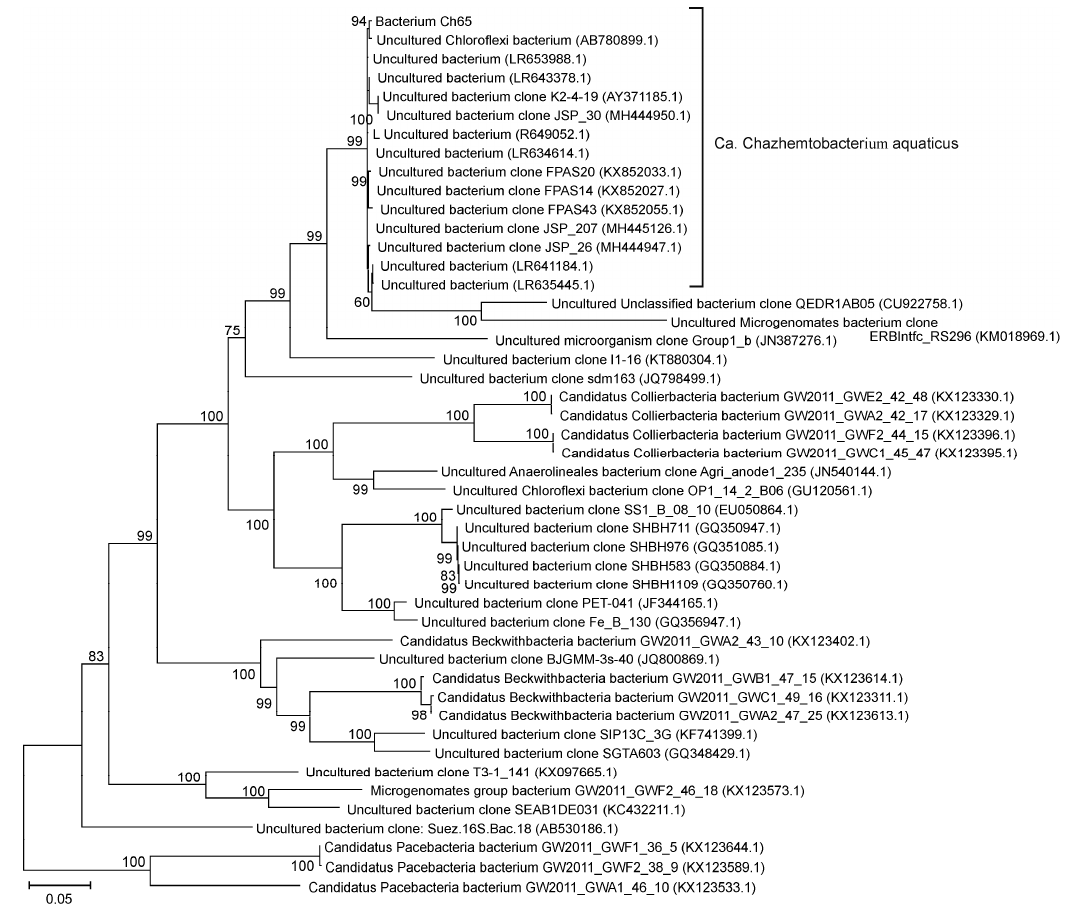
Figure 3. Position of Ch65 genome in the maximum likelihood 16S rRNA gene phylogenetic tree. GenBank accession numbers are shown after the clone names. The scale bar represents substitutions per nucleotide base. Bootstrap values are indicated at the nodes.